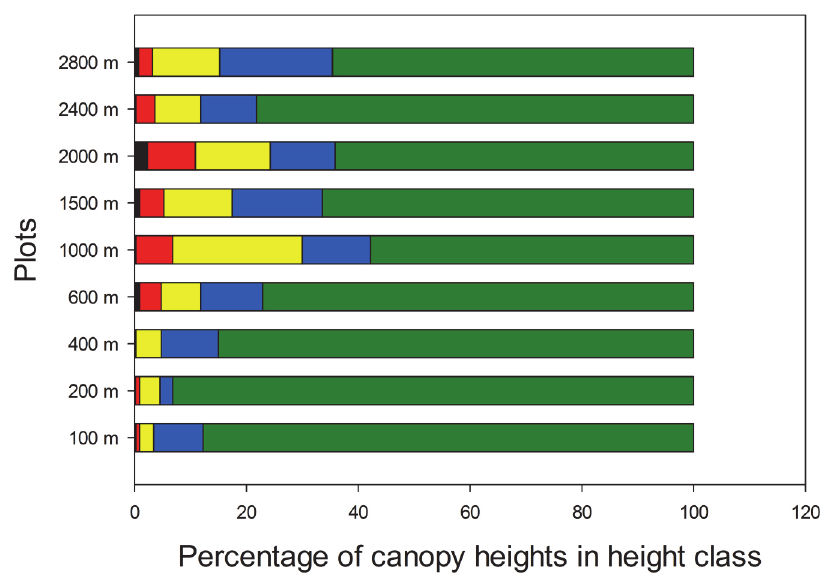
Fig 3. Canopy heights. Distribution of canopy heights along the elevational gradient. Percentages of measurements different height classes are coded left to right as: < 2 m, black; > 2 – 5 m, red; > 5 – 10 m, yellow; > 10 – 15 m, blue; > 15 m green. N = 441 at each site on a 5 x 5 m